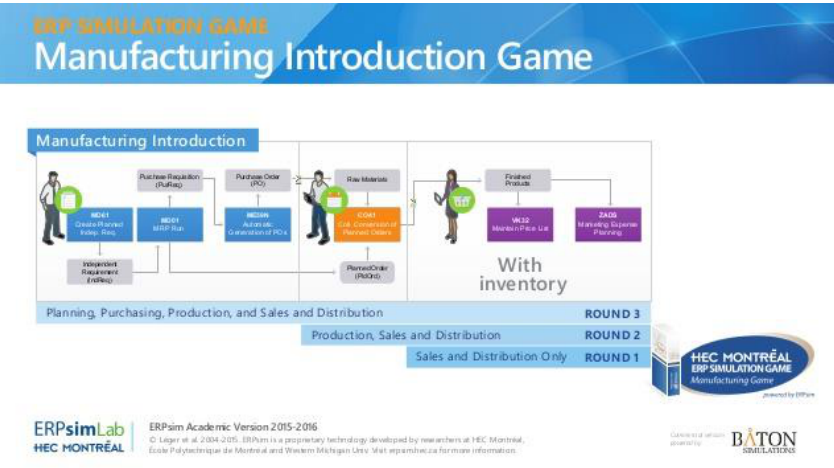
Fig. 3. Introduction to the ERPsim manufacturing simulation